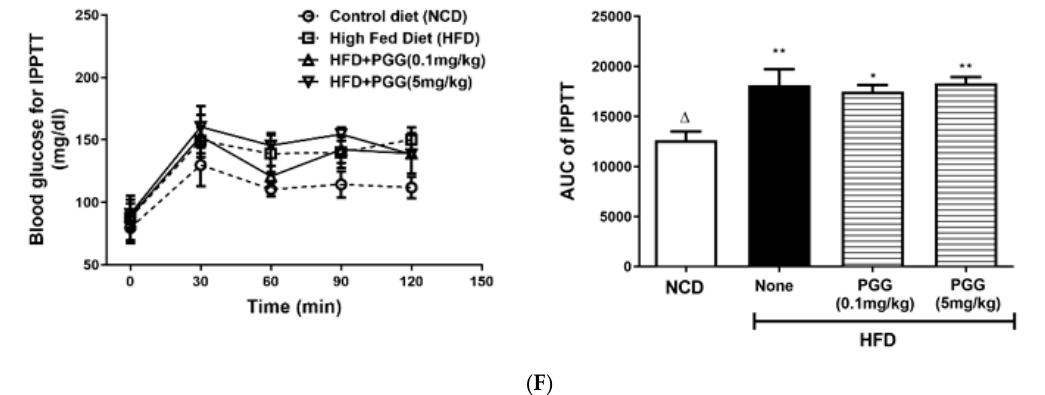
Figure 6. Effect of 12 weeks of β -PGG supplementation on pancreatic islet function and glycaemic control in DIO mice. ( A ) Images of haematoxylin–eosin- (upper) and insulin- (lower) stained pancreatic tissues, ( B ) fasting insulin, ( C ) HOMA-B%, ( D ) glucose tolerance test (OGTT; left) and corresponding area under curve (AUC; right), ( E ) insulin tolerance test (ITT; left) and corresponding area above curve (right), and ( F ) pyruvate tolerance test (IPPTT; left) and corresponding area under curve (AUC; right). Data are shown as mean ± SEM ( n = 4). * p < 0.05 and ** p < 0.01 compared with control diet (NCD) group. ∆ p < 0.05 group and ∆∆ p < 0.01 compared with HFD (none) group.